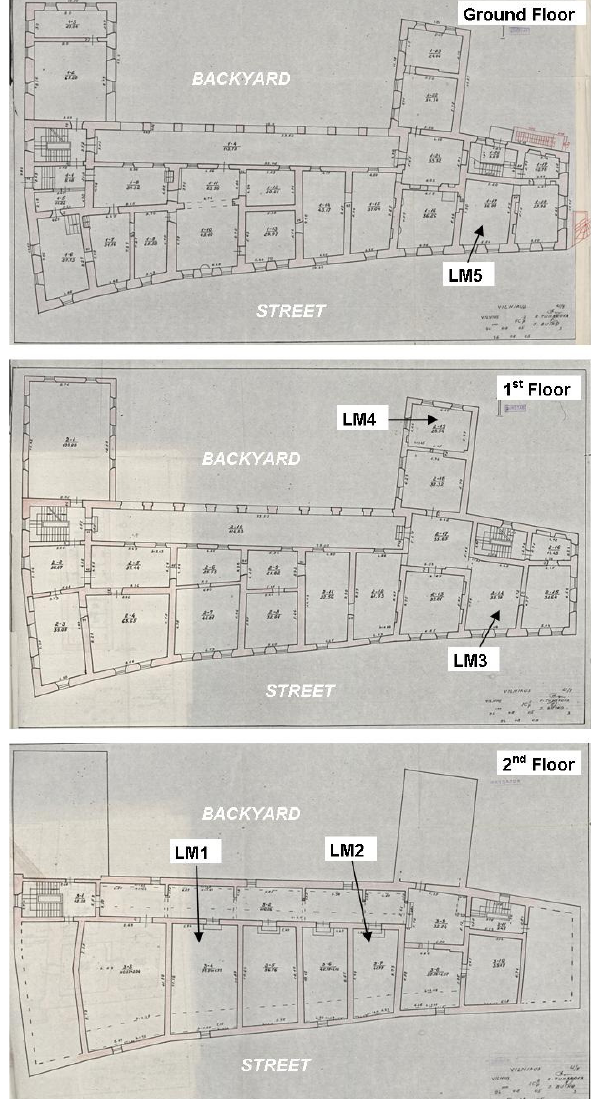
Fig. 1. Distribution of sampling locations in the Lithuanian Theatre, Music and Cinema